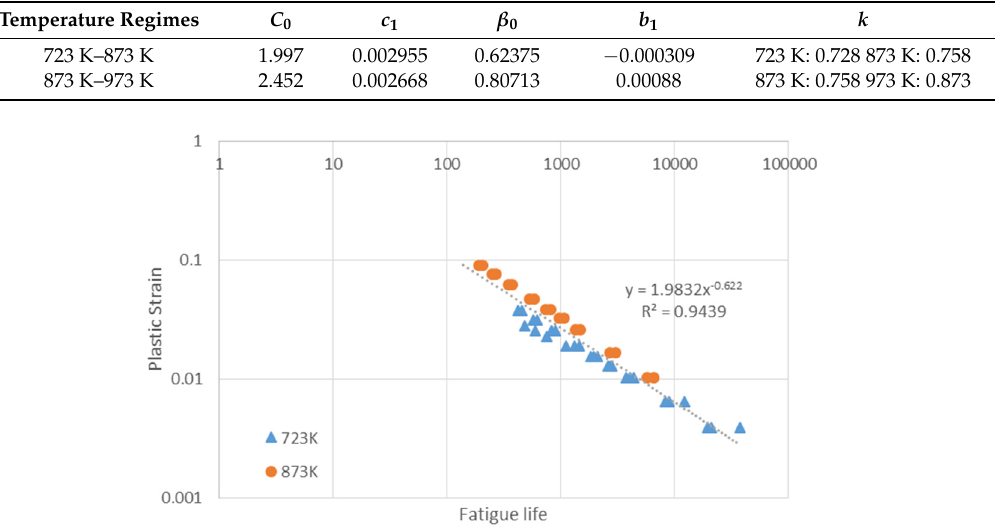
Figure 9. Transformed ε p, ref – N data (below 873 K) of stainless steel 316 using Equation (17).